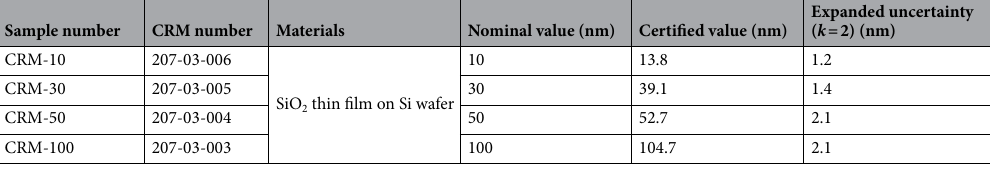
Table 1. Summary of